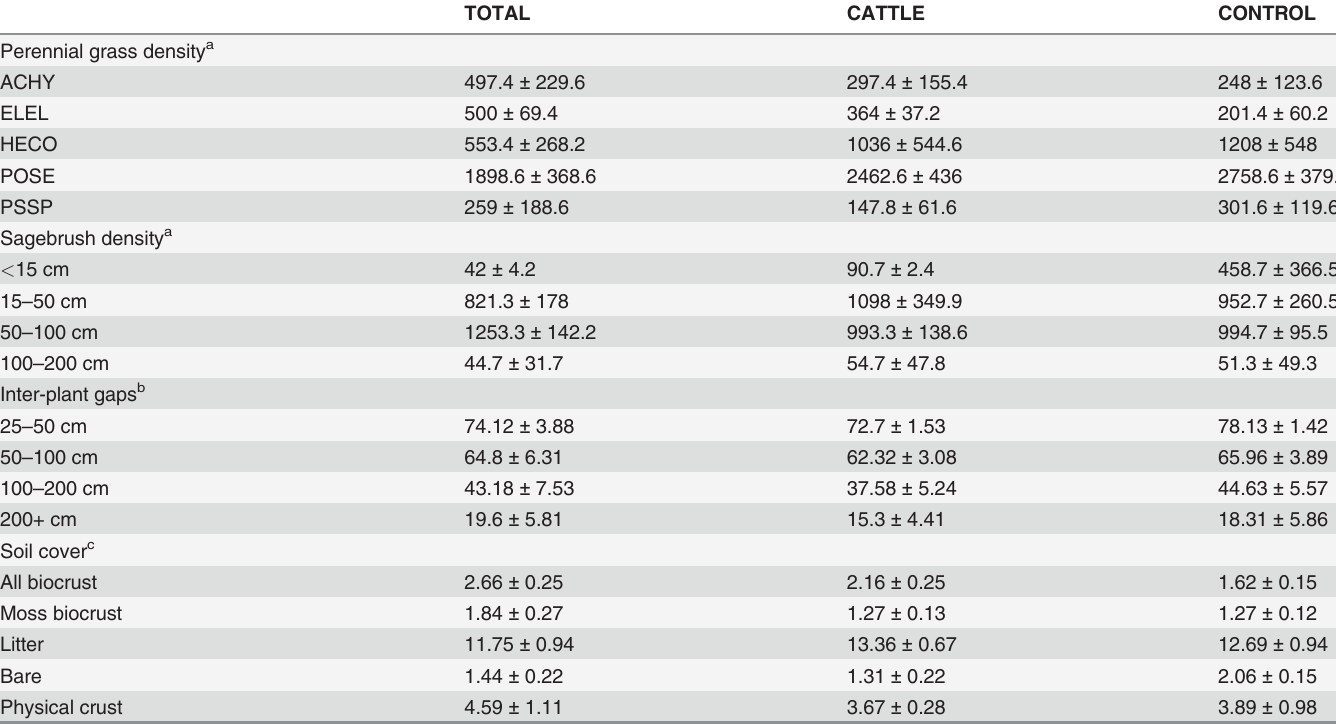
Table 3. Plant densities, gaps, and soil